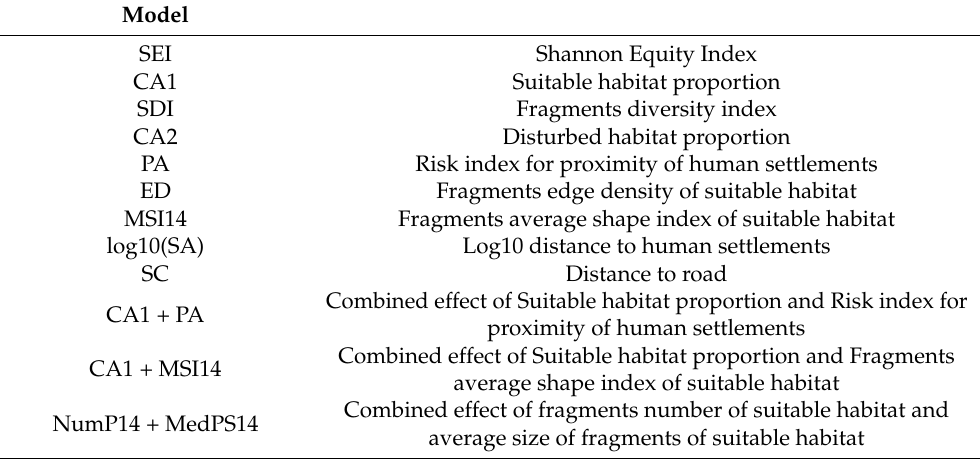
Table A6. Models proposed to examine relationship between expected heterozygosity (He) of Campylorhynchus yucatanicus in the northern Yucatan Peninsula Mexico and landscape structure and